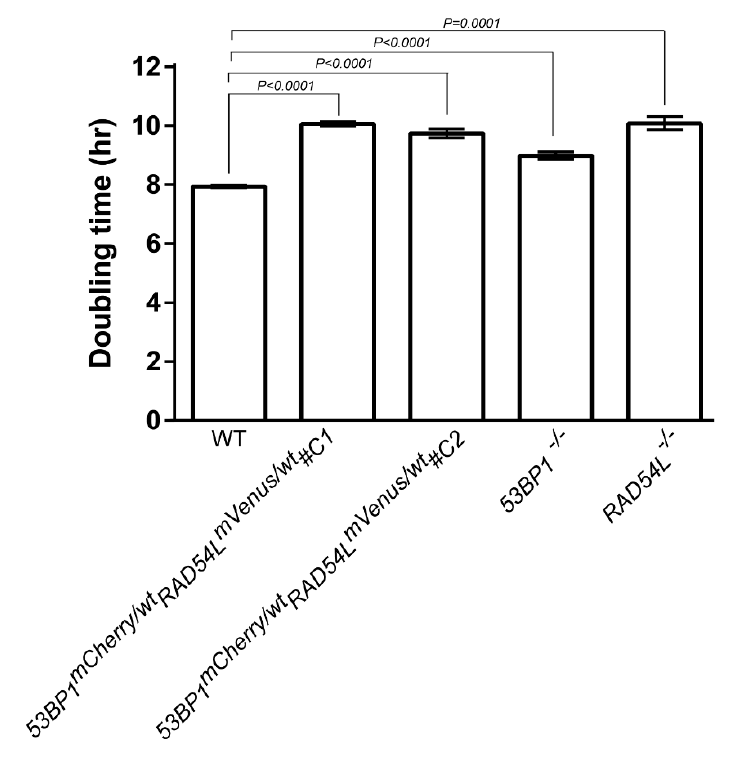
Figure 2. Cell proliferation of biosensor clones was slightly lower than wild-type DT40. Two clones of targeted knockin were generated and they demonstrated the same phenotype. Data are shown as the mean ± standard deviation of three biologically independent experiments. Definitions: 53BP1- mCherry-RAD54L-mVenus#C1, tumor protein p53 binding protein-monomeric Cherry-RAD54-like-